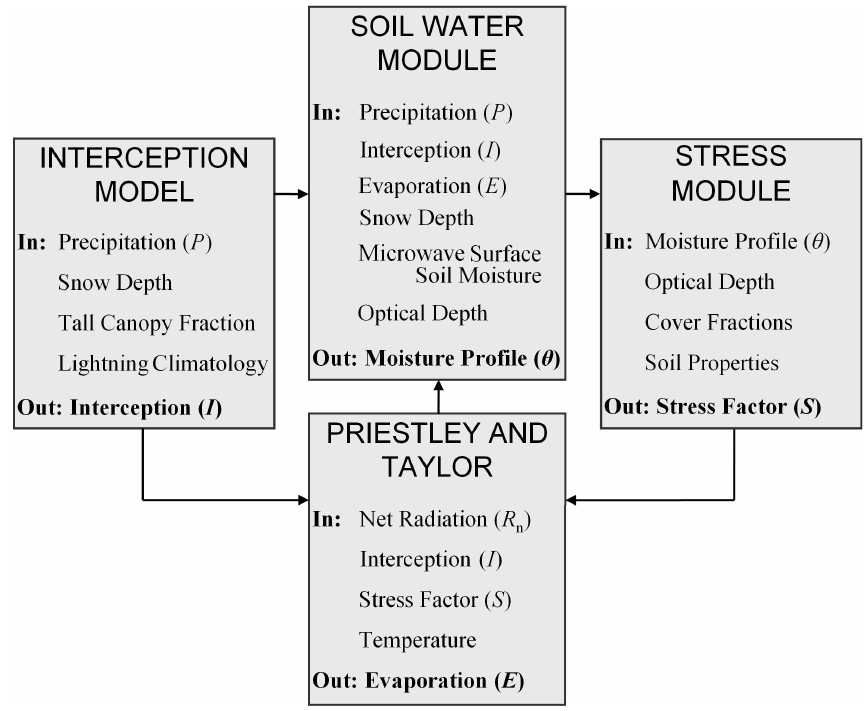
Fig. 1. Schematic overview of GLEAM (adapted from Miralles et al., 2011).